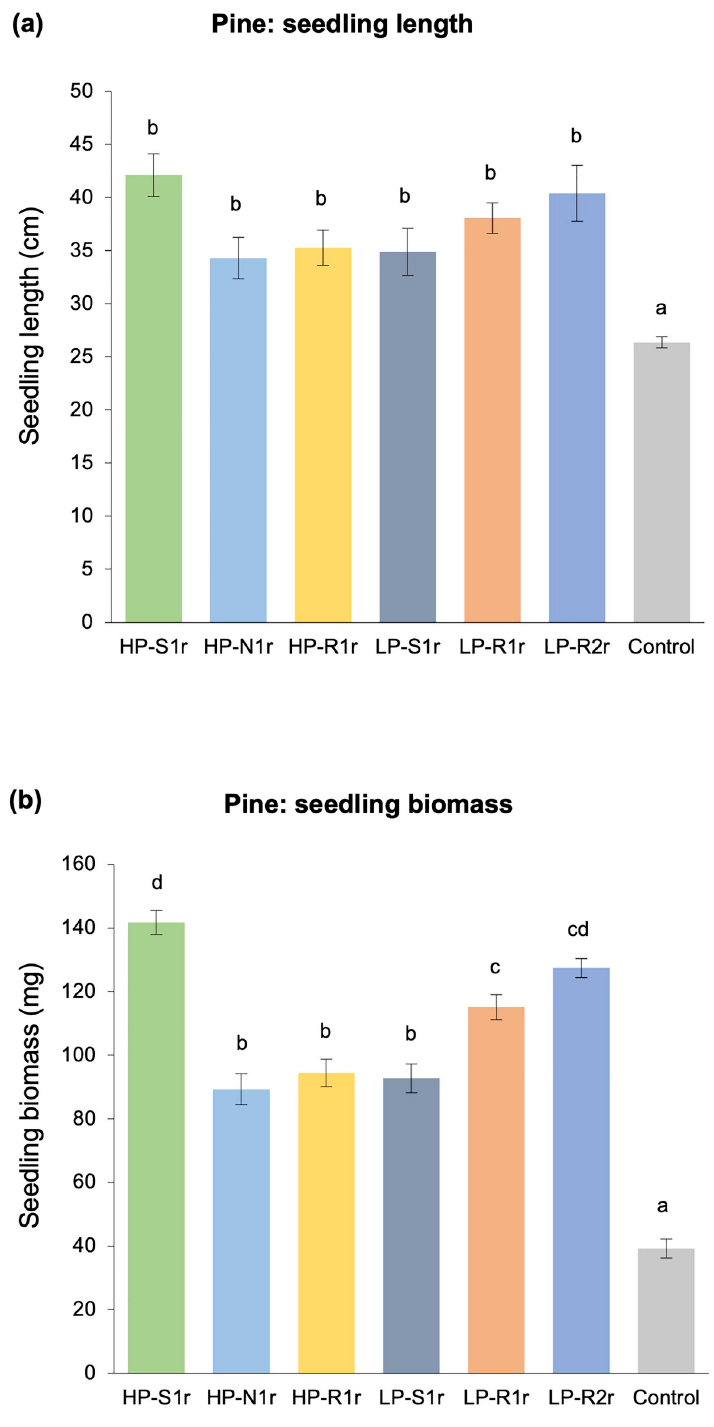
Fig 1. Mean values of (a) length and (b) biomass of 540-day old lodgepole pine seedlings subjected to six bacteria- inoculated ( Caballeronia sordidicola HP-S1r, Pseudomonas frederiksbergensis HP-N1r, Phyllobacterium myrsinacearum HP-R1r, Pseudomonas mandelii LP-S1r, Paraburkholderia phytofirmans LP-R1r and Caballeronia udeis LP-R2r) and one non-inoculated control treatments. Error bars represent standard errors of the mean (n = 10 seedlings per treatment) and bars with different letters are significantly different (P <